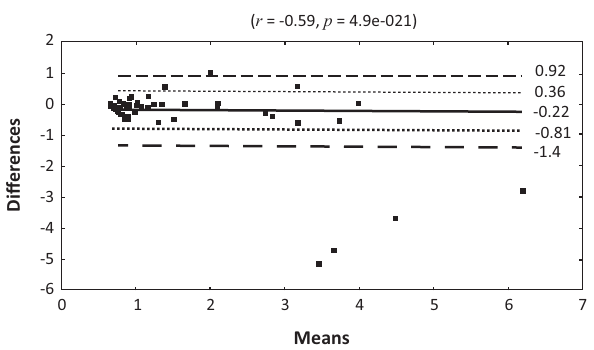
FIGURE 2: A Bland–Altman graph showing the agreement between scores of visual acuities (in min) for both eyes obtained with a Snellen chart and Spectrum LogMAR chart.